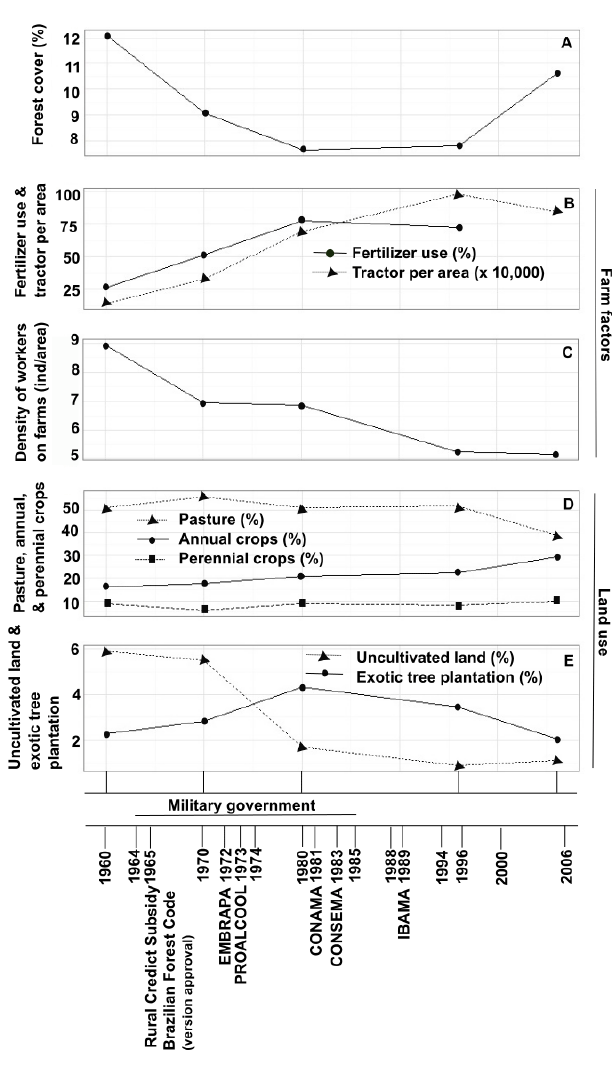
Fig. 2 . Temporal variation in total forest cover percentage (A), farm factors (B and C), and land use (D and E) at the